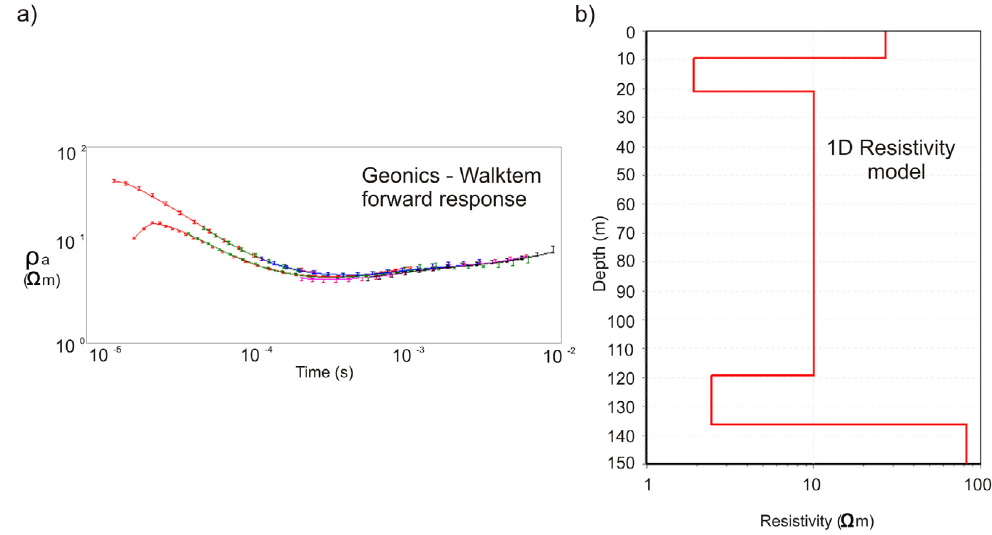
Figure 7. Joint inversion result of the collected Geonics 47 and WalkTEM data at the Italian reference and calibration site. a) Forward re- sponse (solid line) fit the observed data (error bars) within the noise level (set to 3% by default). b) Recovered 1-D resistivity